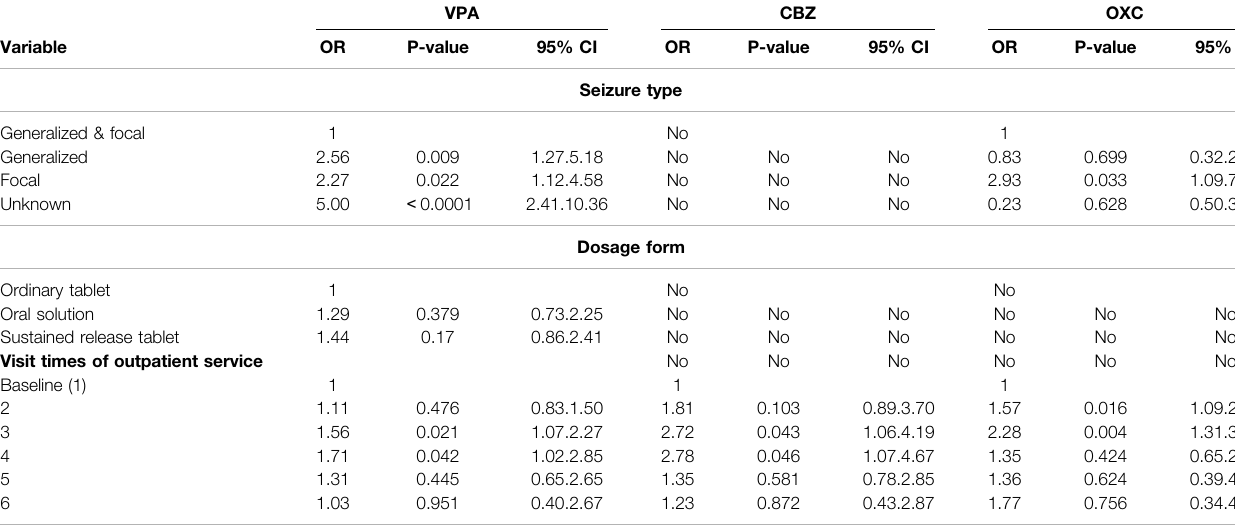
TABLE 2 | Correlation between dummy variables and AED ef fi cacy by ordinal logistic